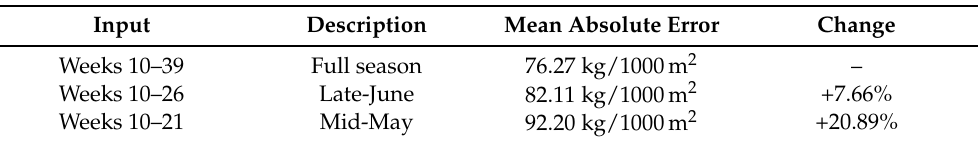
Table 7. The mean absolute error achieved at different times with early predictions. The error increases by 7.66% for late-June predictions and 20.89% for mid-May predictions, compared to predictions made using the whole season.